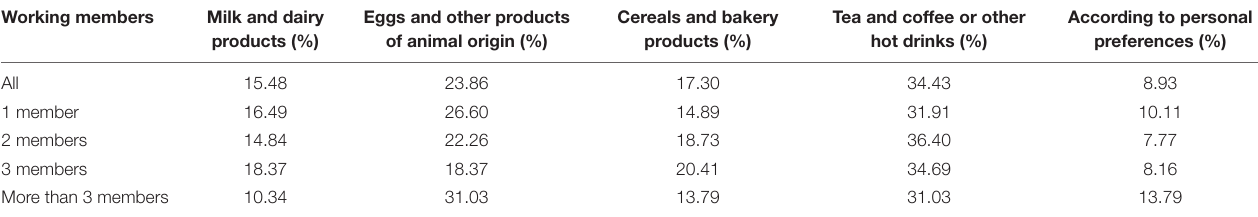
TABLE 2 | The structure of the food consumption of families with one or more members contributing to the family income. Working members Milk and dairy Eggs and other products Cereals and bakery products (%) of animal origin (%) products (%)